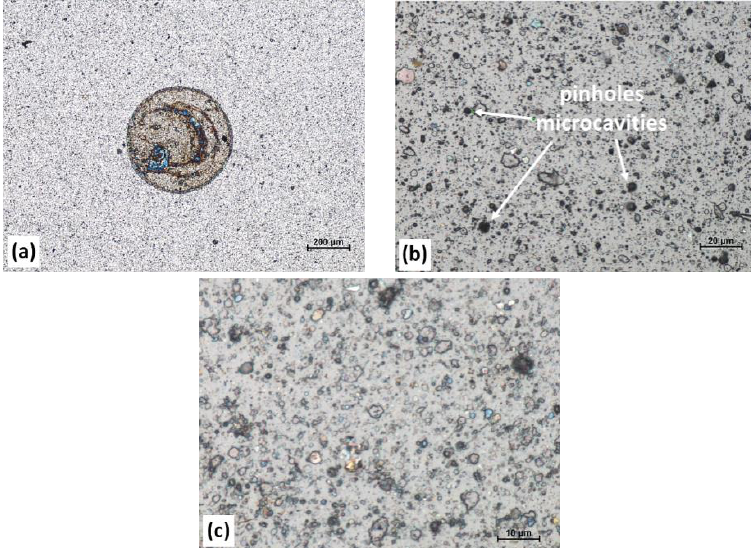
Figure 14. Microscopic (optical) images recorded after five-hour immersion of: ( a ) AlCrSi(1)N, ( b ) AlCrSi(5)N and ( c ) AlCrSi(10)N in the 3.5 wt% NaCl solution. For the respective samples, it was